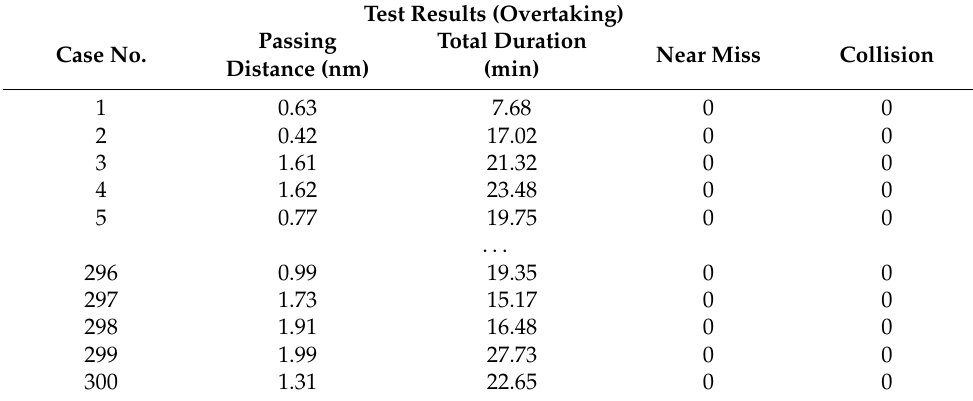
Table 9. Test results in overtaking